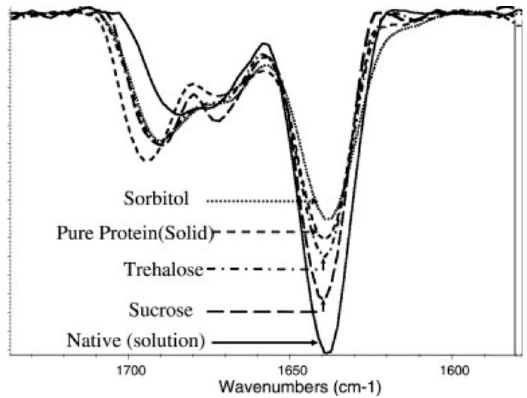
Figure 4. Second derivative FTIR spectra of lyophilized antibody formulations with different ex- cipients used. The ratio between the sugars and the antibody is 1:1. Native structure spectra were recorded with pure antibody in 5 mM phosphate buffer at pH 7. Reproduced with permission from [41], Elsevier, 2005.